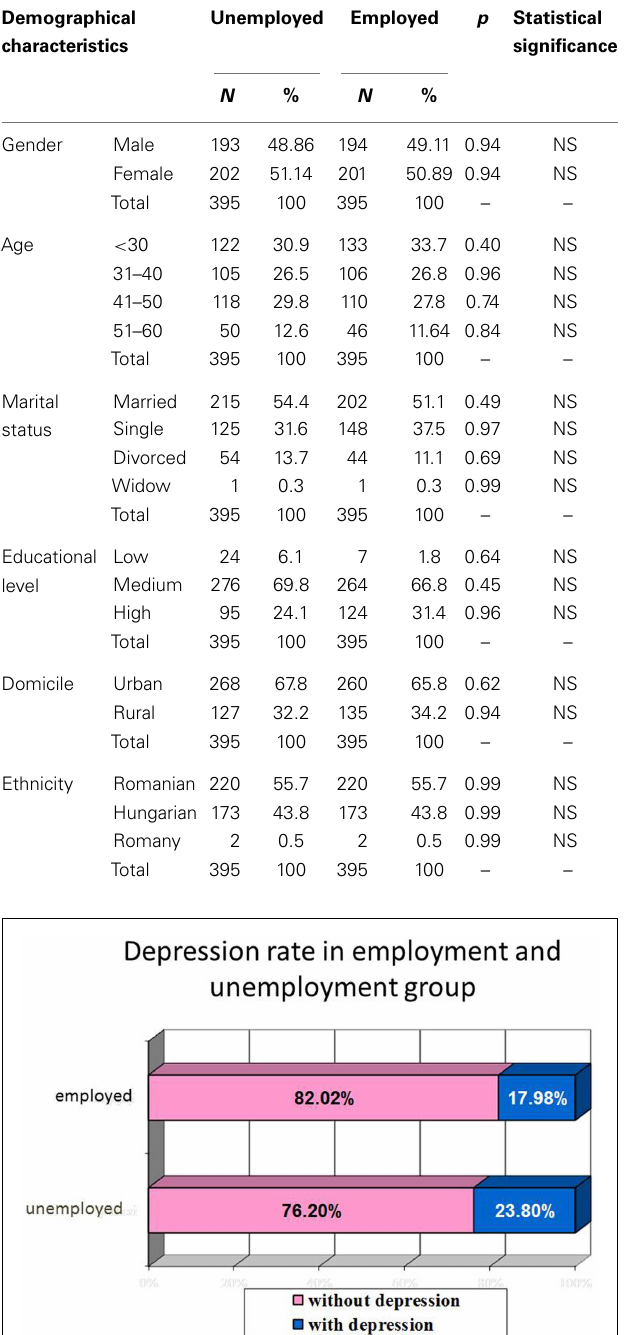
Table 1 | Demographical characteristics of both groups: employed and unemployed .